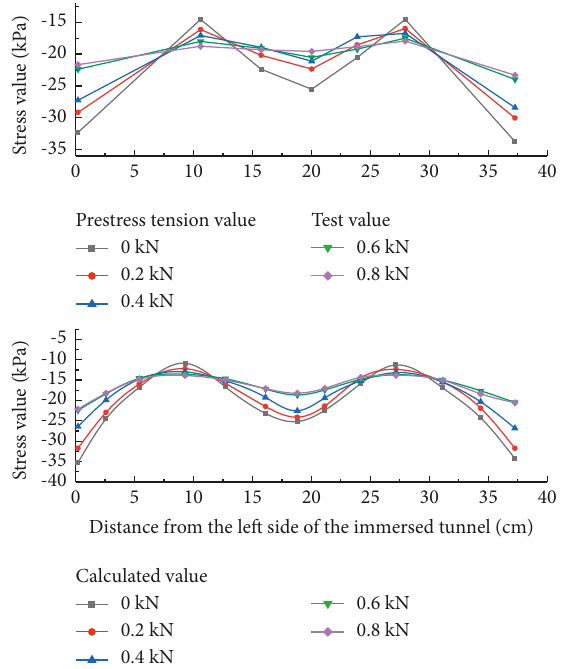
Figure 19: Comparison of measured stresses and finite element analysis